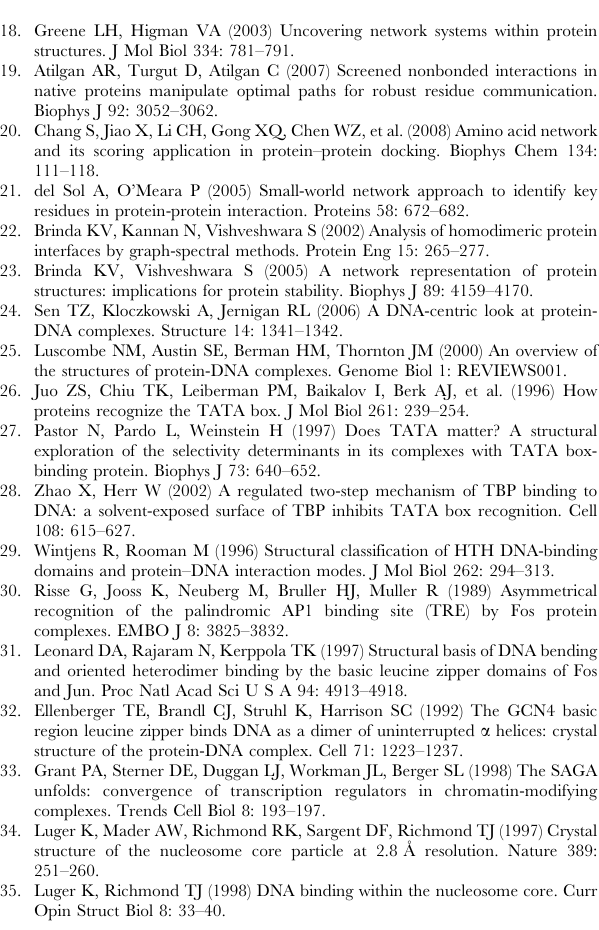
Figure S2 A bipartite cluster based classification of DNA- binding proteins. P-p clusters are highlighted with yellow color for phosphate and brown for interacting amino acids. P-S clusters are highlighted with green color for deoxyribose sugar and purple color for the interacting amino acids and P-B clusters are highlighted with red color for bases and blue color for the interacting amino acid residues. Table S1 A comprehensive list of the protein-DNA complexes studied and the general clusters and hubs information.